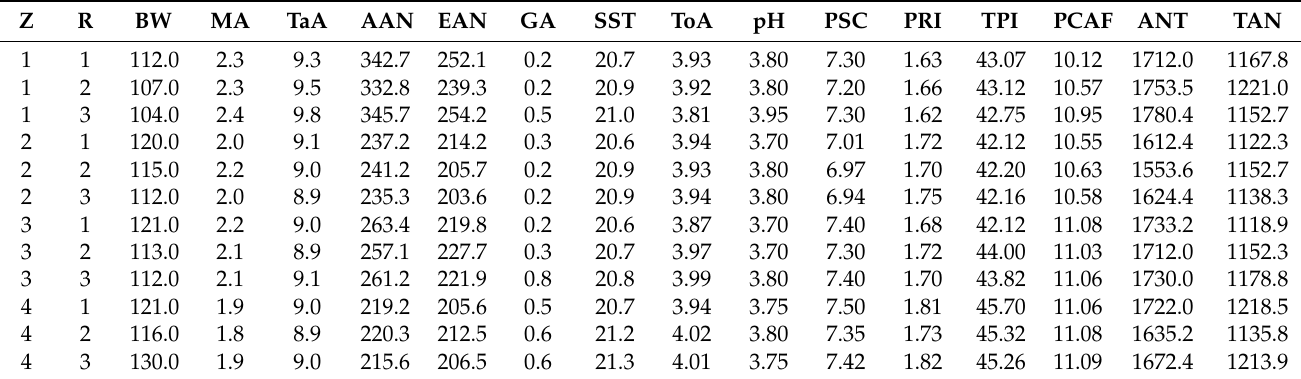
Table 3. Laboratory results for 15 must quality variables.